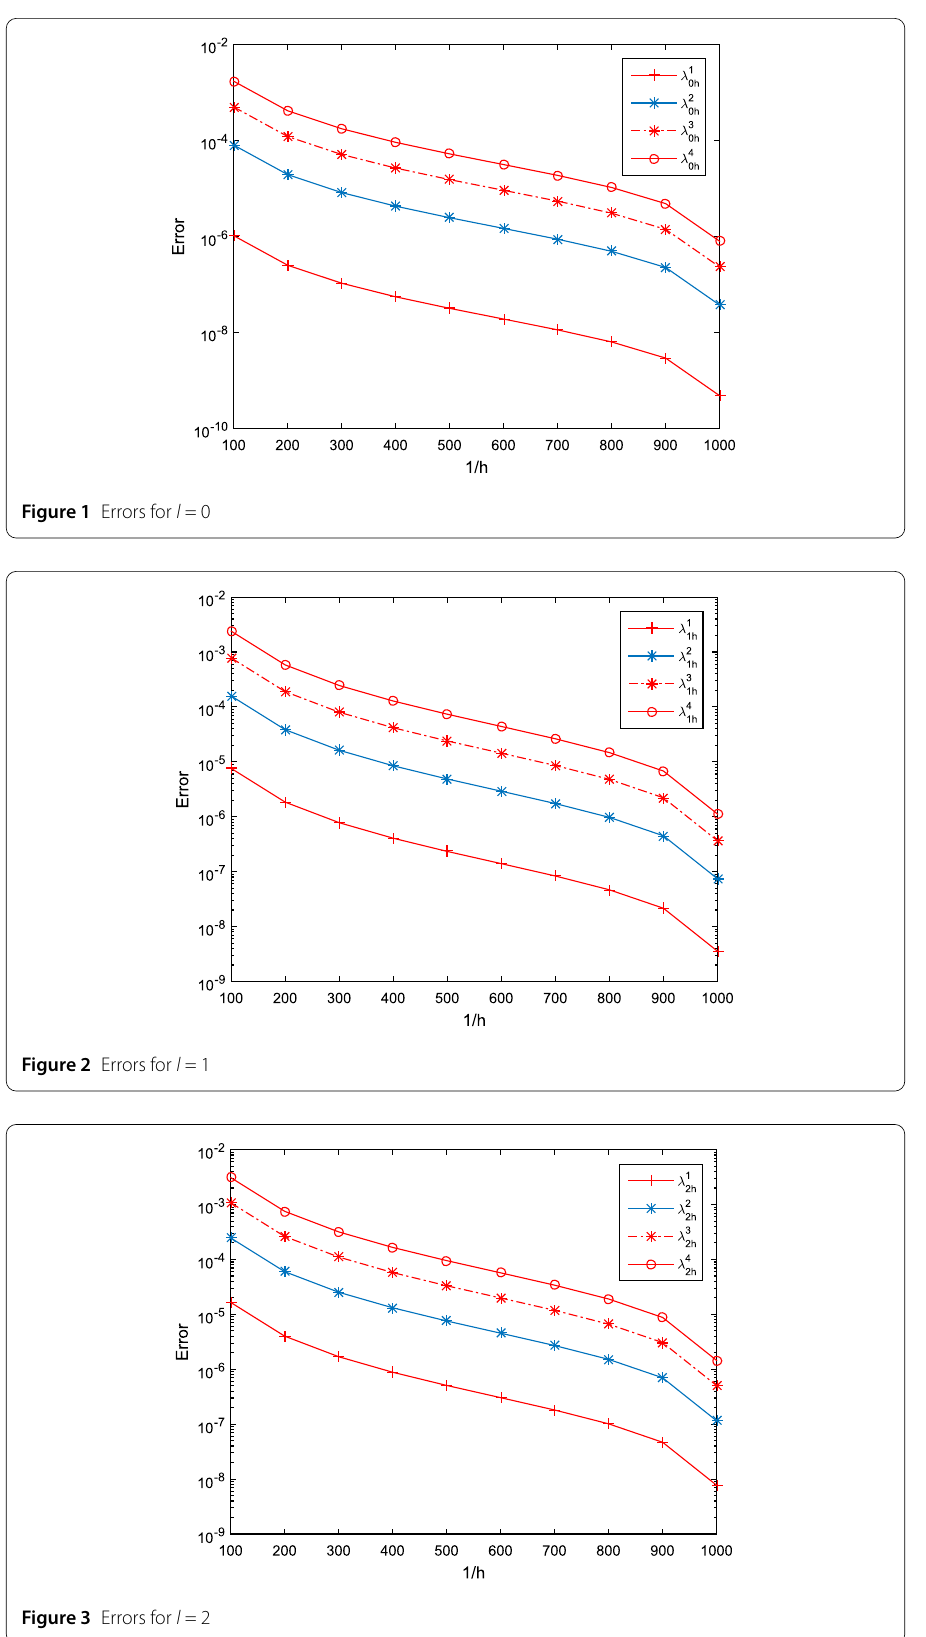
Figure 3 Errors for l =